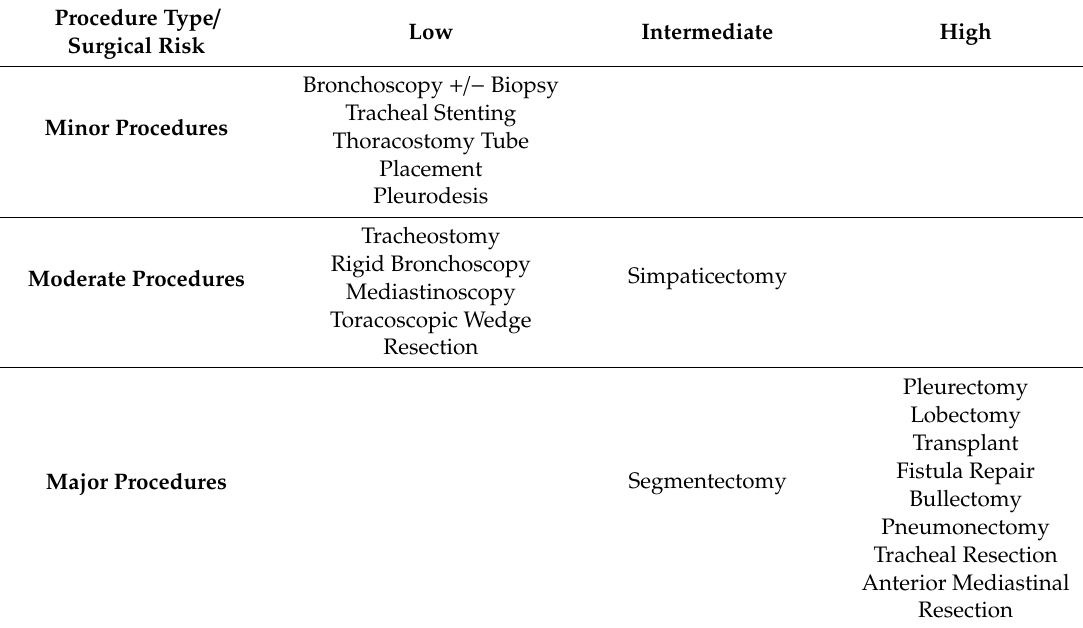
Table 1. Thoracic surgery and risk of developing post-operative atrial fibrillation.